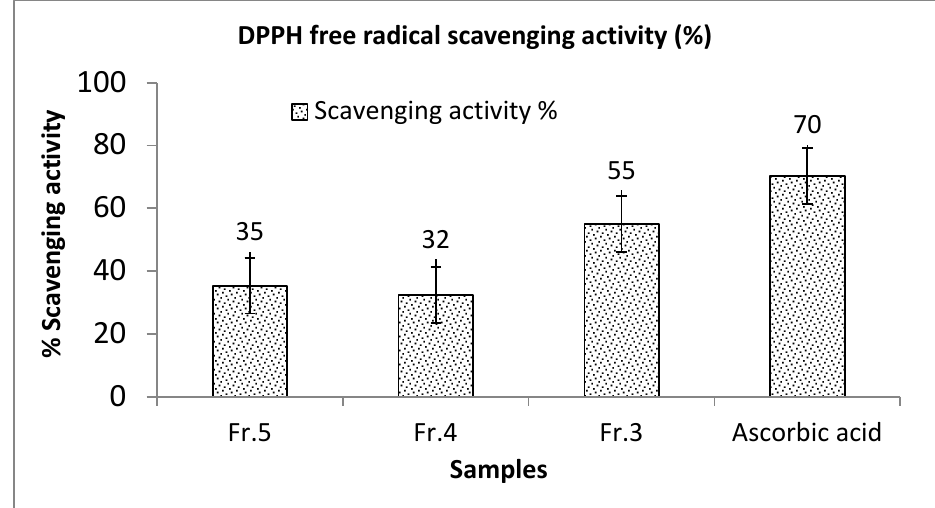
Figure 3. DPPH free radical scavenging activity (%). The results are the average of two replicate experiments, and the error bars show standard deviations.